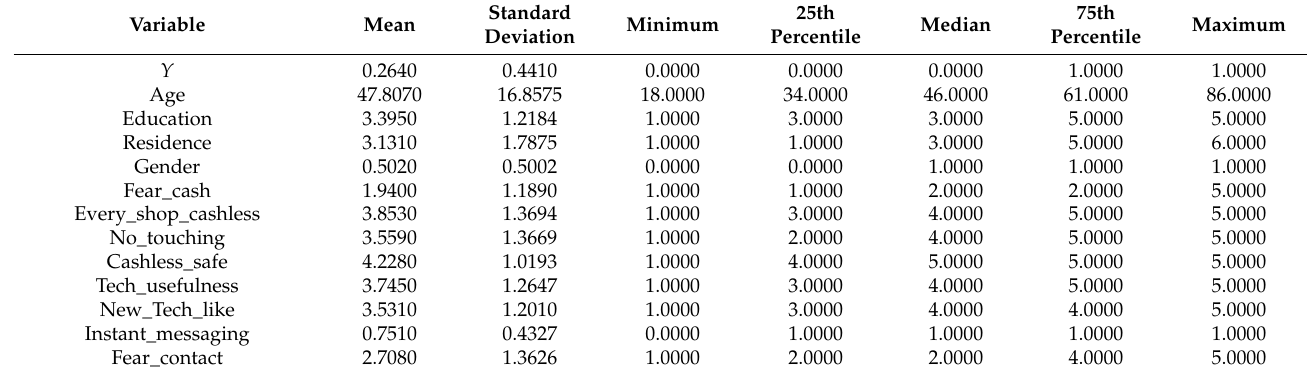
Table 3. Summary Statistics.